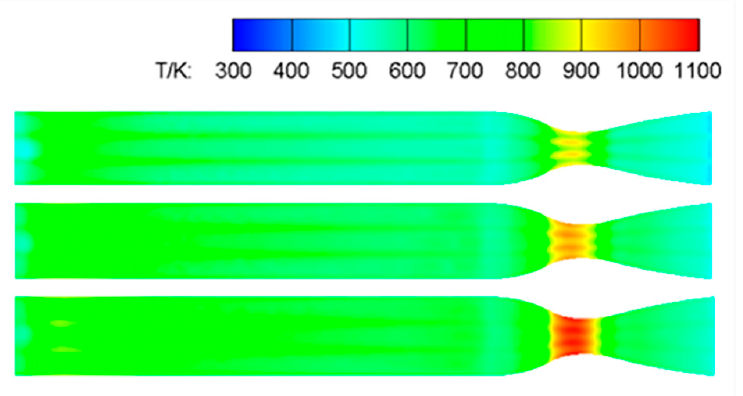
Figure 23. Temperature contour on the inner wall thickness under 0.8 mm ( top ), 1.0 mm ( middle ), and 1.2 mm ( bottom ).